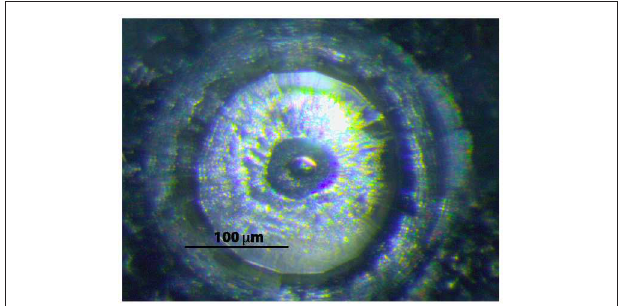
FIGURE 1 | Microphotograph of the sample after laser heating at 110 GPa. Single shot laser heating resulted in the formation of a quasi-spherical pure carbonate glass that was removed from the gasket for EPMA and/or SEM